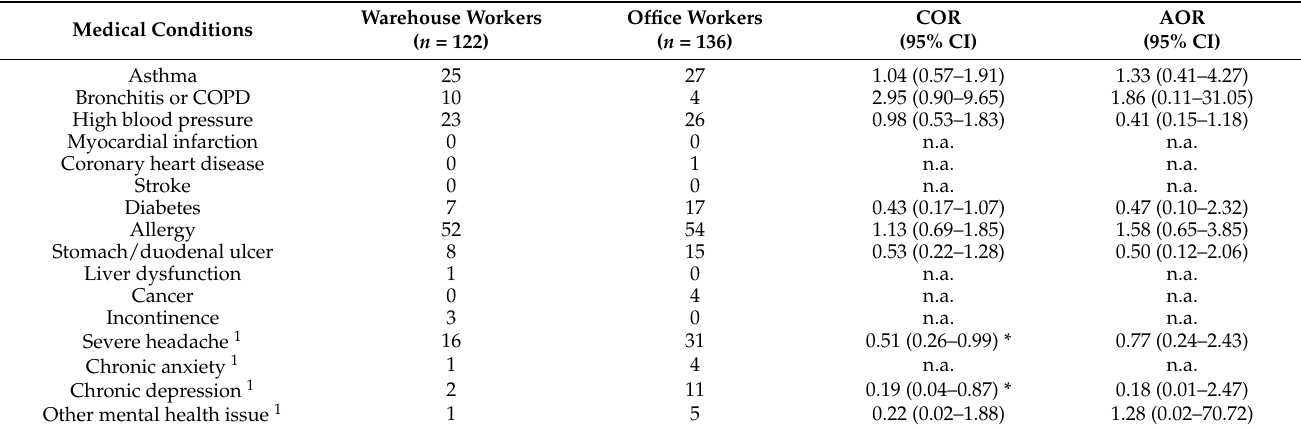
Table 2. Diagnosed medical conditions among warehouse and office workers at logistics